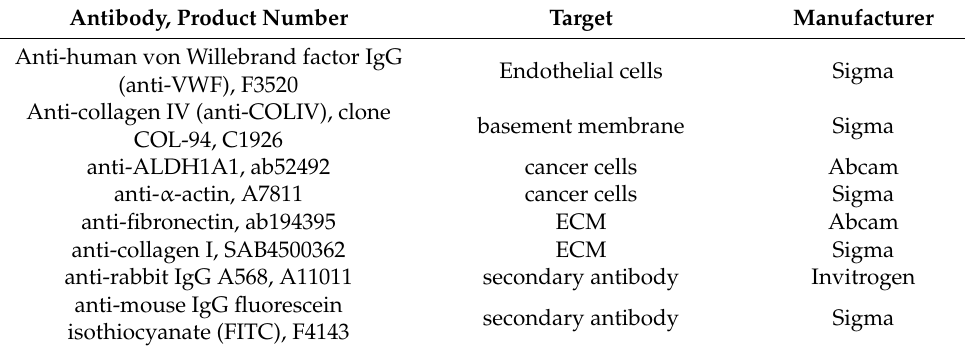
Table 2. Antibodies utilized in the study, their targets, and manufacturers.